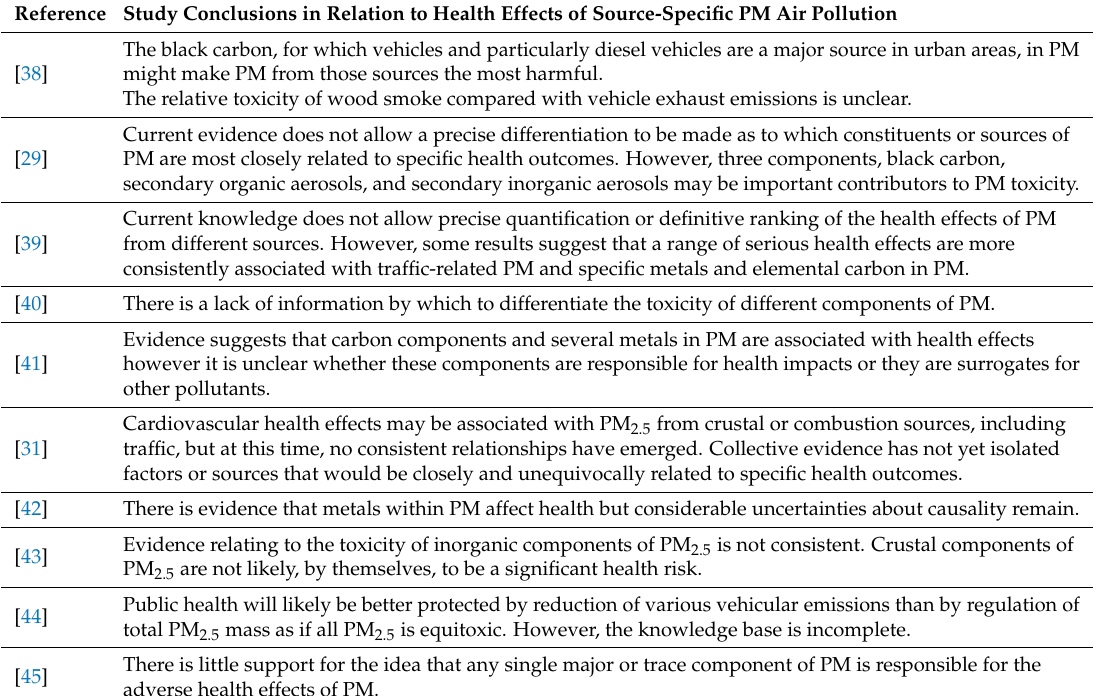
Table 1. Conclusions from previous reviews of the differences in the health effects of different components and sources of PM air